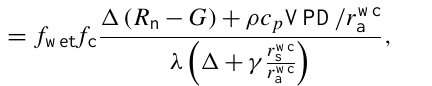
Table 1. Table summarizing the model inputs. Listed are the main inputs, product selected, original temporal and spatial resolutions, and the satellite sensors used to derive the product. Variable Models Product Resolution Sensors Surface radiation All SRB 3-hourly, 100km Several VIS-IR sensors Surface temperature SEBS IPMA polar twice daily, 1km AATSR geostationarity hourly, 5km MSG-2, MT-SAT, GOES-12 Surface meteorology ERA-Interim 3-hourly, 75km Assimilation of temperature All satellite and humidity SEBS, PM-MOD, PT-JPL other meteo wind SEBS observations f APAR, LAI SEBS, PM-MOD, PT-JPL From ESA 8 days, 1km VEGETATION, MERIS, MODIS GlobAlbedo Soil moisture GLEAM ESA-CCI daily, 25km SSM/I, TMI, AMSR-E, ASCAT Precipitation GLEAM CMORPH 30min, 15km AMSU-B, AMSR-E, TMI Snow water GLEAM ESA daily, 1km